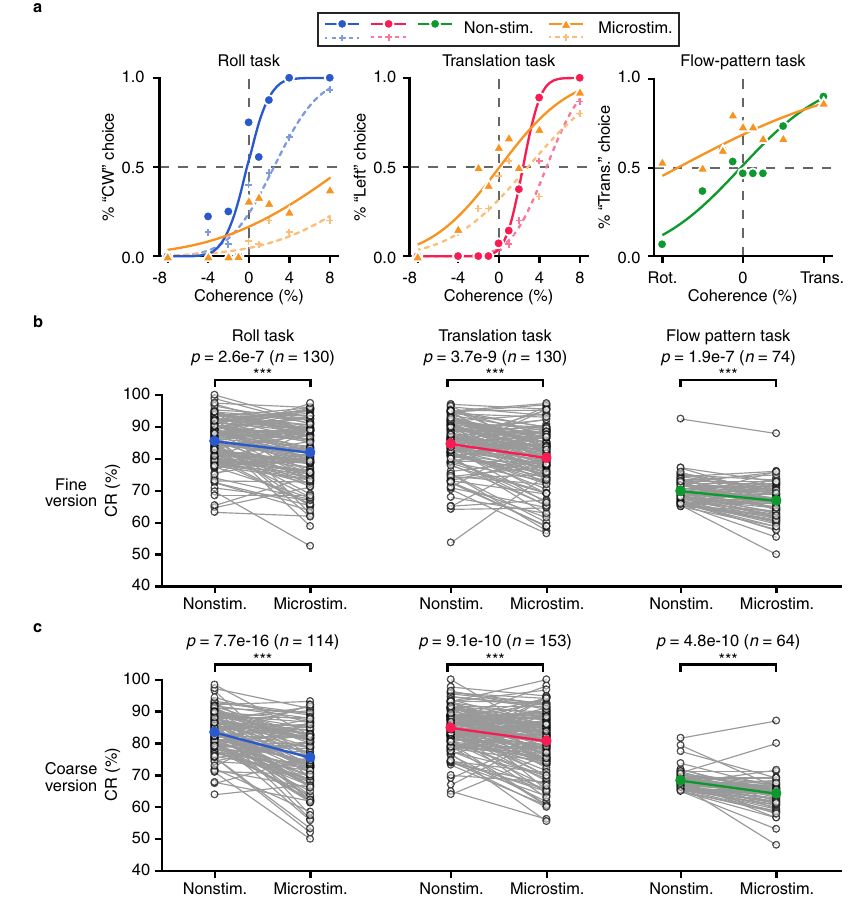
Fig. 7 | Microstimulation effect on the animals ’ performance discriminability. a Example psychometric functions for non-stimulated trials and microstimulated trials.SameformatasFig.4a.Microstimulation-inducedchangeofCRunder fi ne( b ) and coarse ( c ) version. Open circles, CR of each individual site with or without stimulated; Colored fi lled circles, mean CR. Horizontal lines, p value for two-tail